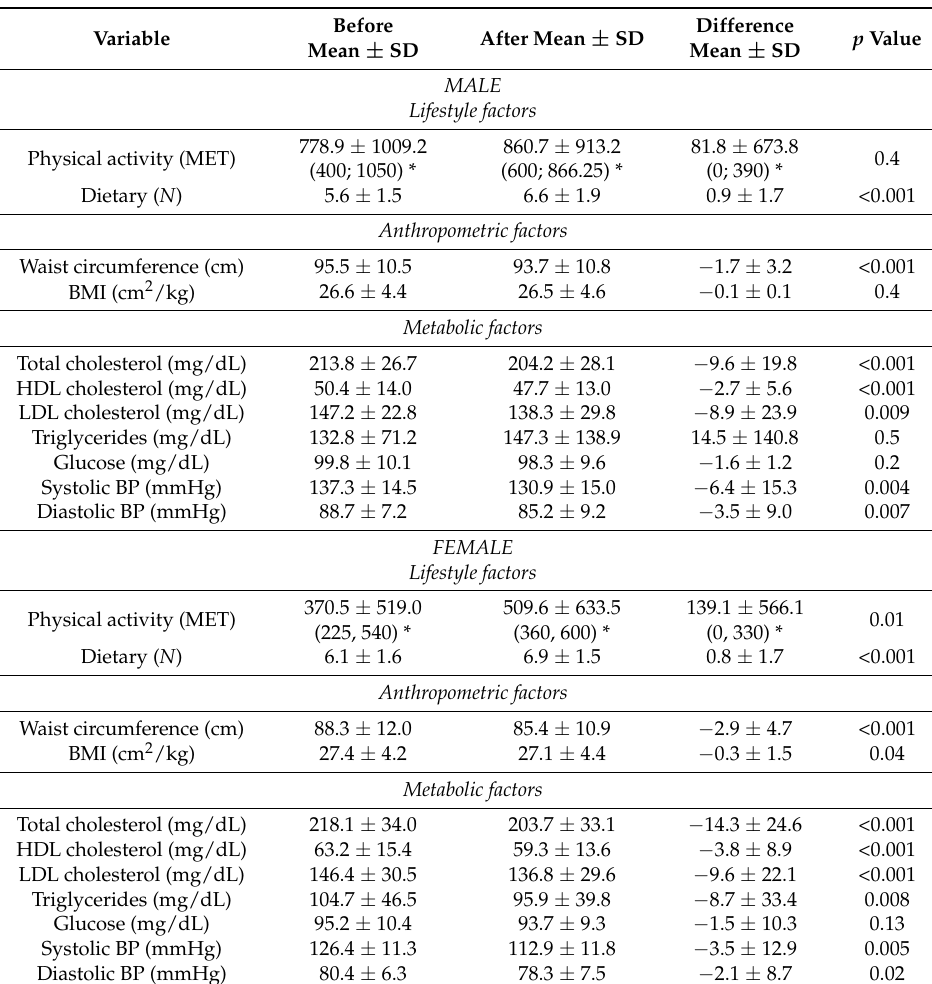
Table 3. Analysis before and after intervention, by